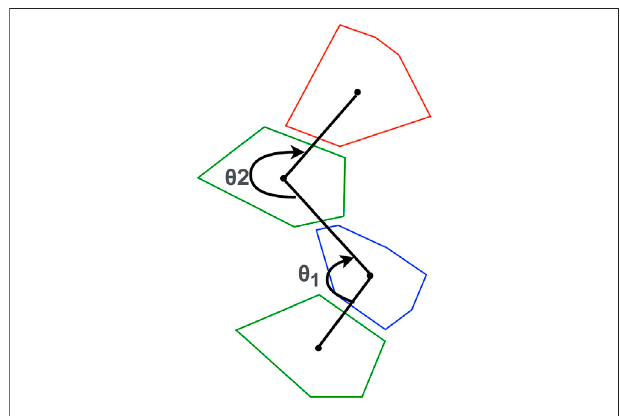
FIGURE 3 | A sample leg design. The average of the two angles determines the complexity of the